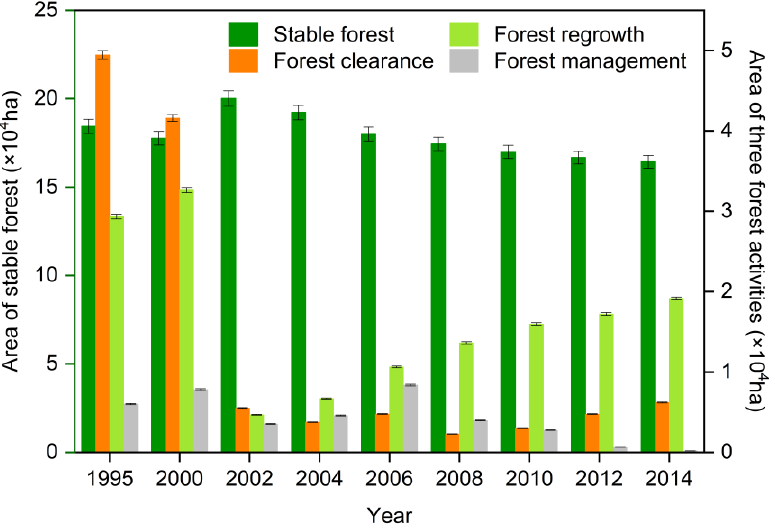
Figure 5. Changed area of four forest activities and the area bias estimated by the stratified samples based on “Good Practice” strategy over 1995 – 2014.